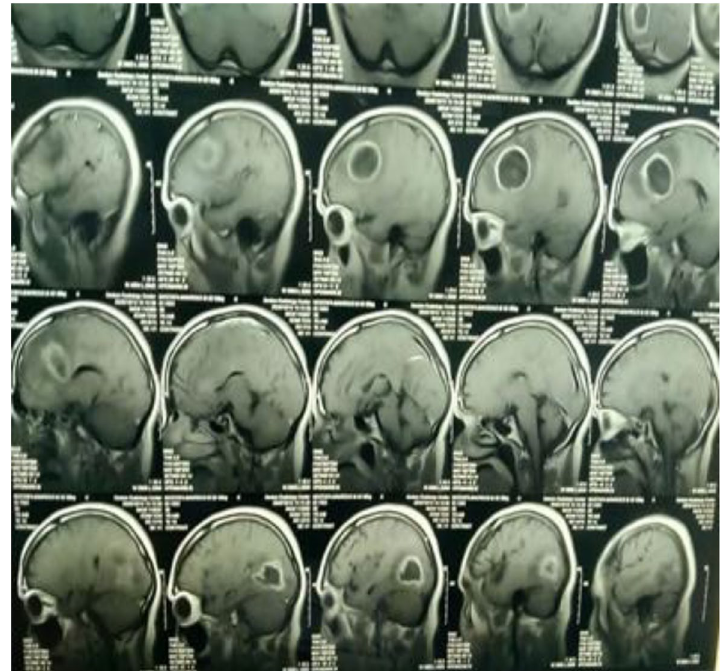
Fig. 2 MRI with contrast sagittal and coronal sections show left frontal and right parietal—intra-axial hypodense brain lesions with a margin of enhancement